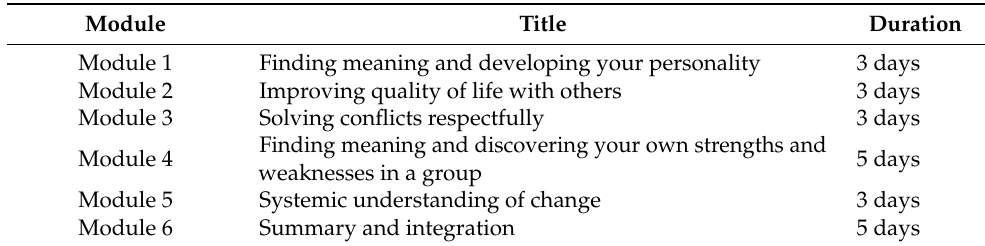
Table 5. Duration and titles of the training modules. Module Title Duration Module 1 Finding meaning and developing your personality